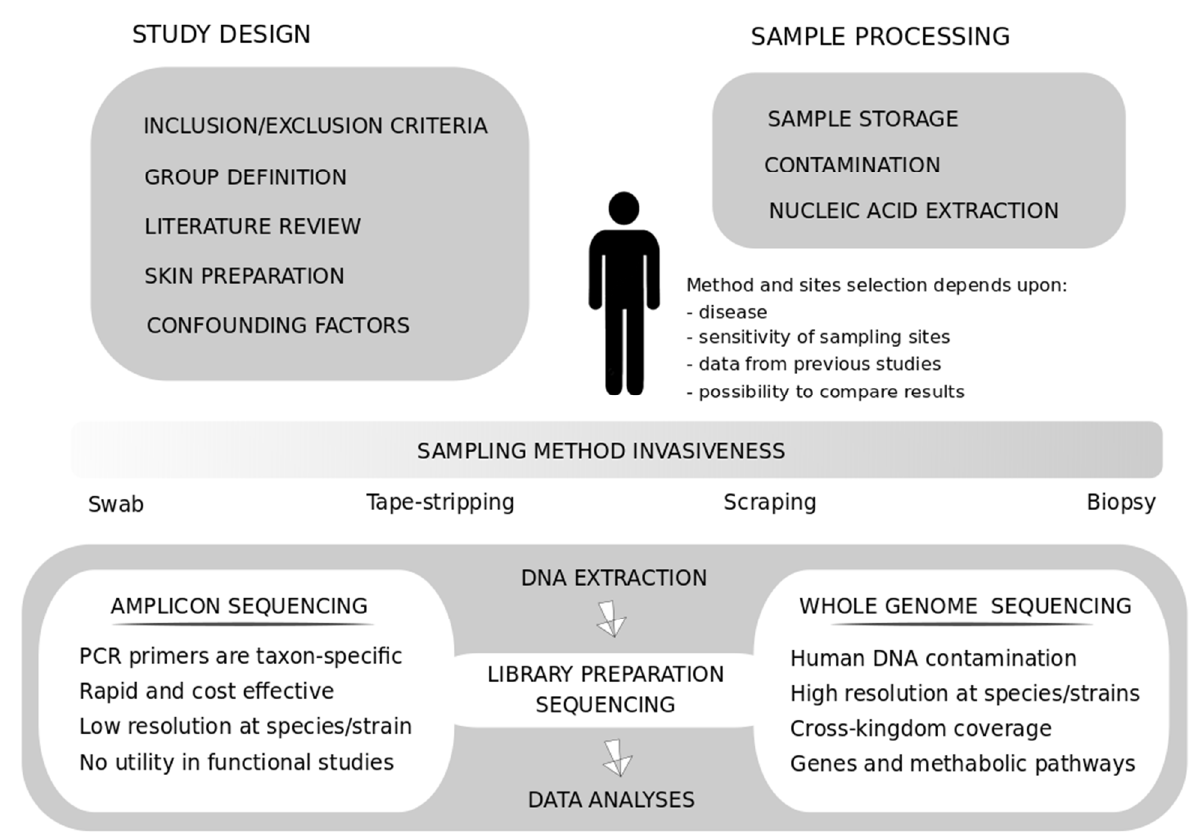
Figure 1. Schematic representation of several methods, processes, and steps to consider in skin microbiota research study design.